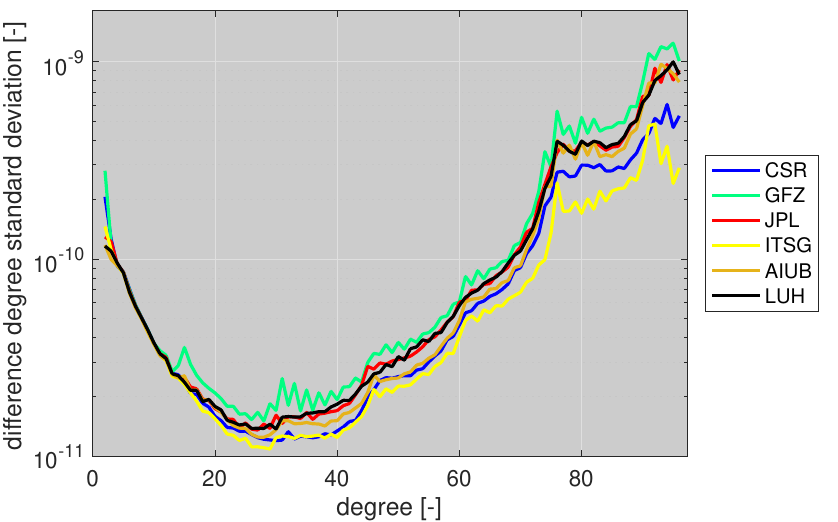
Figure 1. Mean difference degree standard deviations of monthly gravity field solutions from June 2018 until December 2020 with regard to a mean field. Mean field is the average of solutions of all ACs. C 20 coefficients are zero tide in all